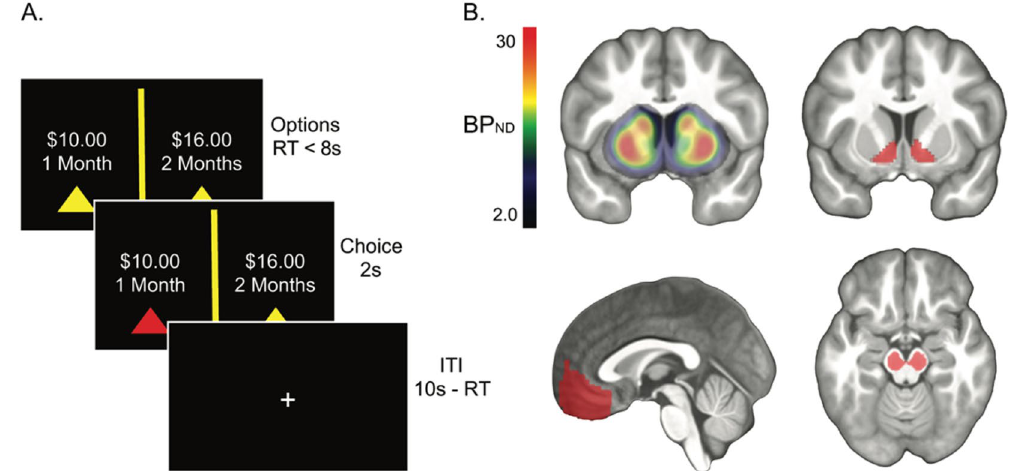
Figure 1. ( A ) Task outline. Participants were given up to 8 seconds to indicate a preference for a smaller-sooner or a larger-later monetary reward, after which their choice was highlighted for two seconds. Choice trials were separated by an inter-trial-interval (ITI) scaled by the difference between 10 seconds and the choice response time so that every trial lasted 12 seconds from choice onset to ITI. ( B ) Top Row : Mean BP ND map (left) and ventral striatum ROI (right) from which the average DA D2 receptor availability was extracted for each subject. Bottom Row : Ventromedial prefrontal cortex (left) and midbrain (right) ROIs from which subjective value parameter estimates and DA D2 receptor availability were extracted for each participant. BP ND map and ROIs shown are overlaid on the mean participant T1-weighted image in MNI